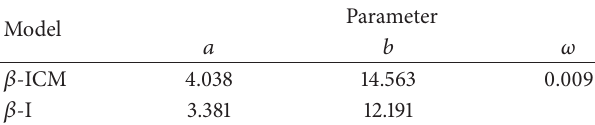
Figure 4: The cumulative distribution functions of 𝑆 20 , for a scale of limiting correlations, 𝜔 , under the 𝛽 - 𝛽 model.